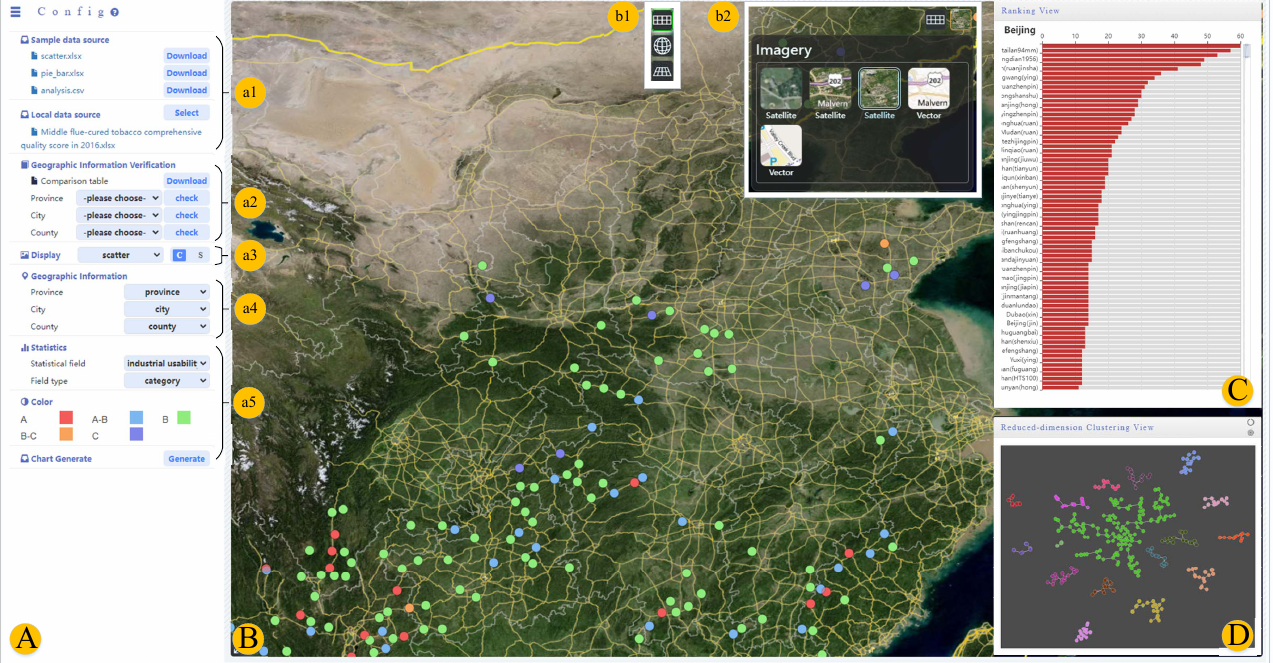
Figure 2. System interface. ( A ) Configuration panel provides configuration information for the system. ( a1 ) Data import reads remote and local data. ( a2 ) Geographic information verification performs accurate matching of provincial, municipal, and county names. ( a3 ) Analysis pattern selec- tion determines multiple data analysis patterns. ( a4 ) Geographic information configuration matches corresponding fields of provinces, cities, and counties in the data set. ( a5 ) Different parameter config- urations are provided for multiple patterns. ( B ) The map view shows the data spatial distribution by combining scatter, pie, and bar graphics. The system presents the three map perspective modes— ( b1 ) 3D, 2D, and 2.5D—and five map layers ( b2 ) of the image and vector map to visualize different perspectives and map conveniently. ( C ) Ranking view cooperates with the map to show data details and values of data points. ( D ) The reduced-dimensional clustering view cooperates with the map to analyze the similarity distribution of tobacco high-dimensional data in the geographical